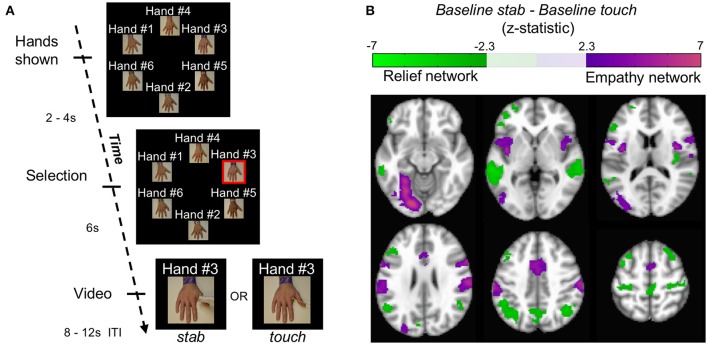
Localizing empathy. (A) In each trial, hands appeared with impartial text labels. The computer selected a hand, and that hand received either a stab or a touch. (B) Whole brain contrasts of baseline stab>baseline touch and baseline touch>baseline stab yielded 6 and 7 significant clusters, respectively (p < 0.05 FWE) shown here in MNI coordinates from −12 mm to 58 mm in 14 mm increments.